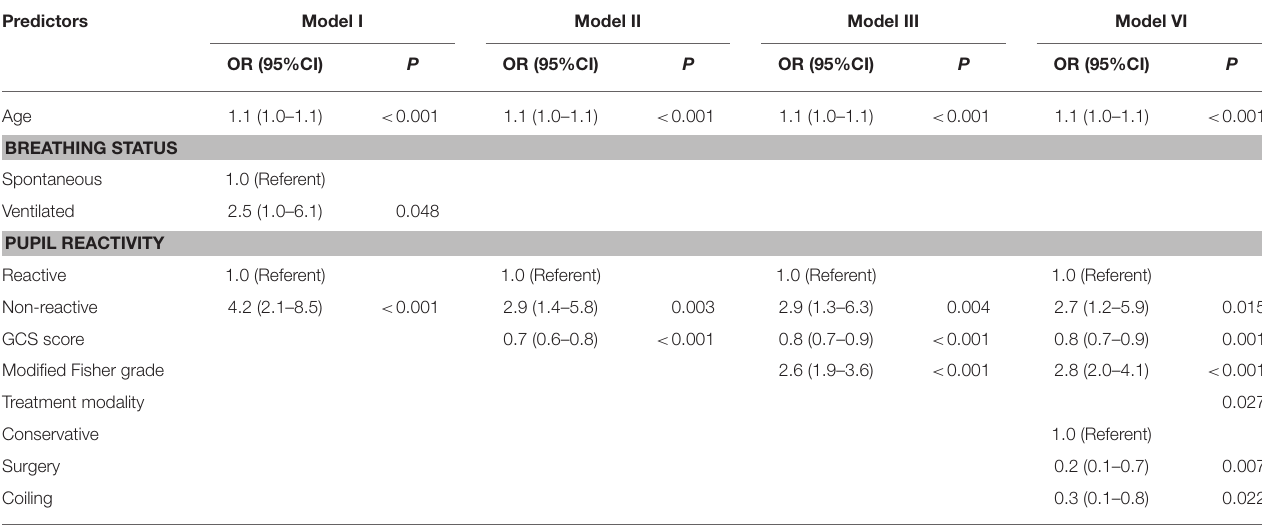
TABLE 2 | Multivariate analysis for predictors of poor outcome at 12 months based on the experimental design of four different models.